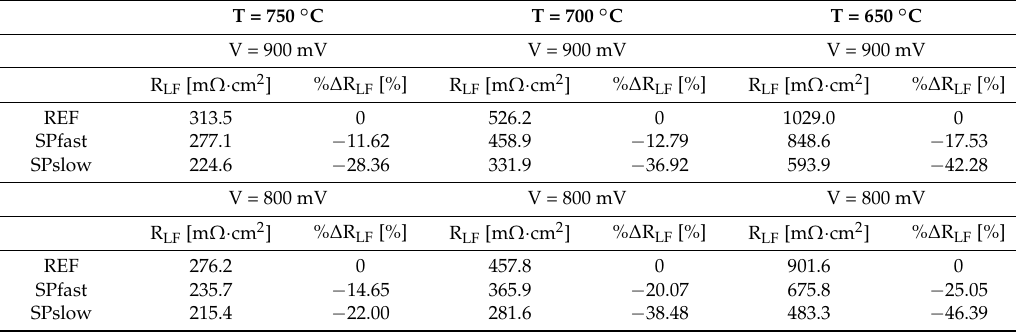
Table 4. Measured values of the low frequency resistance R LF for the tested samples.